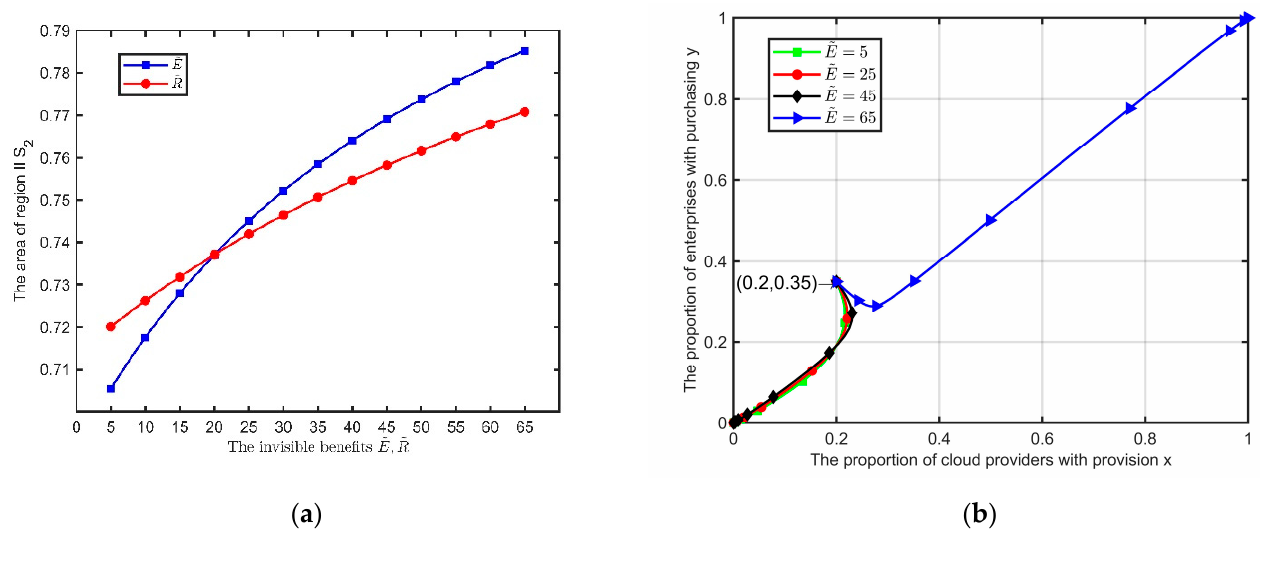
~ ~ and R ~ ; (c) The evolutionary paths